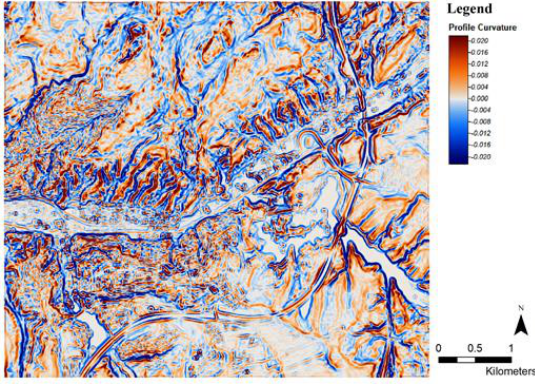
Figure 8. Profile curvature map of the study area The SPI indicates a measure of the abrasive power of flowing water (Zakerinejad and Maerker, 2015) (Figure 9). SPI is used for landslide susceptibility maps because of being denotive of the potential erosion energy of the sediments (Kakembo et al., 2009). The TWI is used in order to express the locations and dimensions of the water-saturated areas in the topographical sense (Moore et al., 1991) (Figure 10).